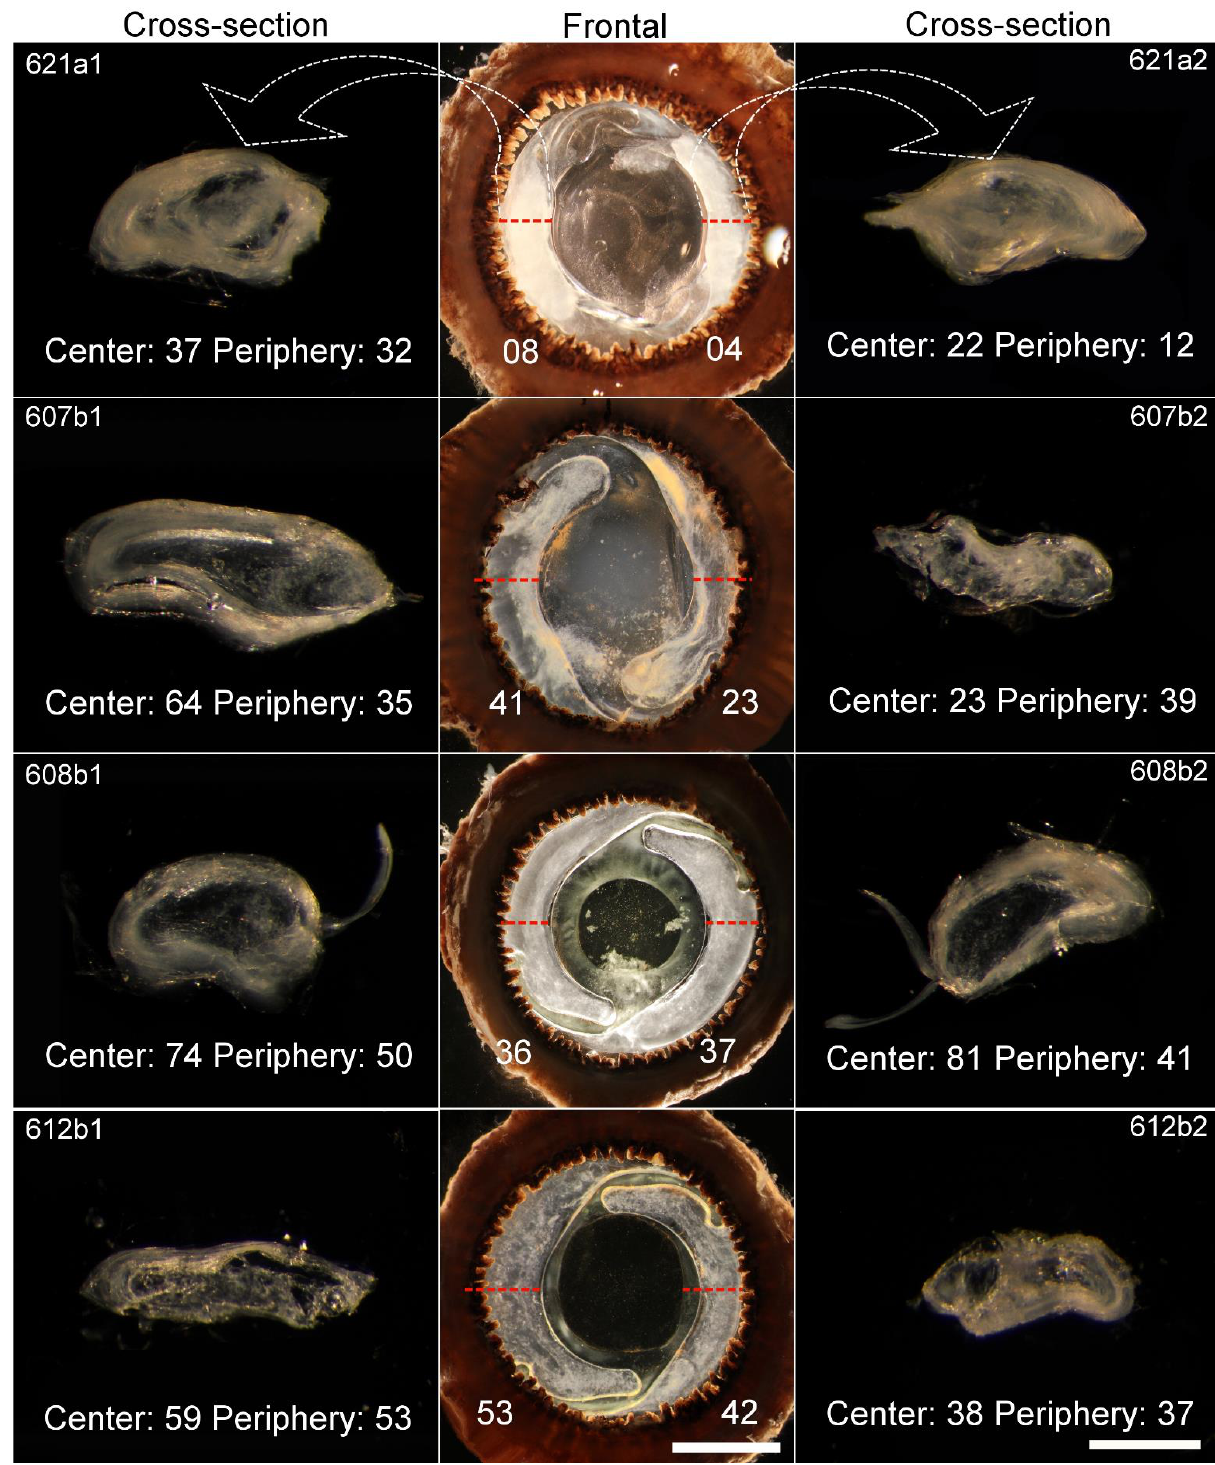
Figure 1. Frontal (center column) and cross-section (left and right columns) images of samples visualized with dark field illumination. The red and white dashed lines indicates where the cross-sections where made. The numerical values indicate the degree of transparency in each sample (100 = Black/transparent, 0 = White/opaque). In frontal samples it indicates the values of each side of the Soemmerring’s ring. In cross -section samples it indicates the central and peripheral values. Scale bars = 4 mm (frontal) and 800 µm (cross sections).